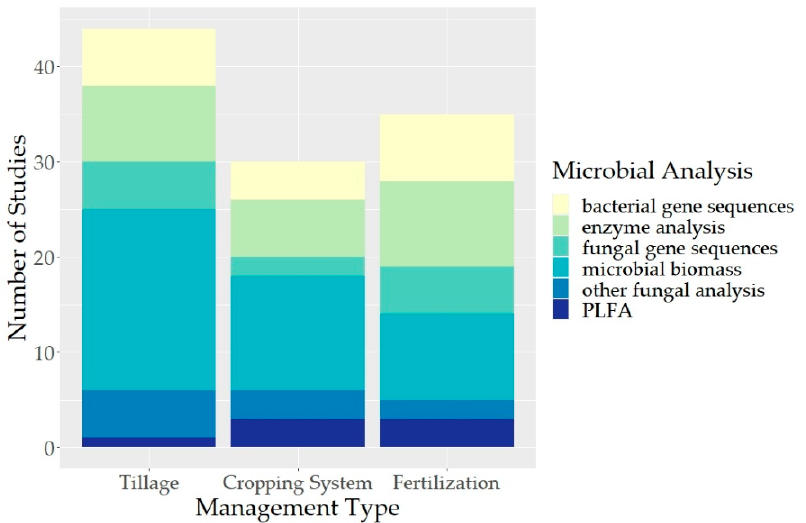
Figure 2. Number of reviewed studies by management type and type of microbial analysis. Many studies included more than one type of management strategy and/or microbial analysis. Only the most common analyses are shown. Other fungal analysis includes arbuscular mycorrhizal fungi (AMF) root colonization, glomalin extraction, and enzyme-linked immunosorbent assay (ELISA). PLFA stands for phospholipid fatty acid analysis.